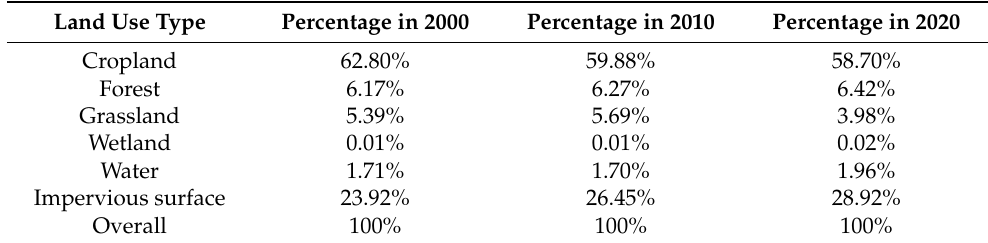
Table 8. Percentage of area occupied by different land types from 2000 to 2020. Land Use